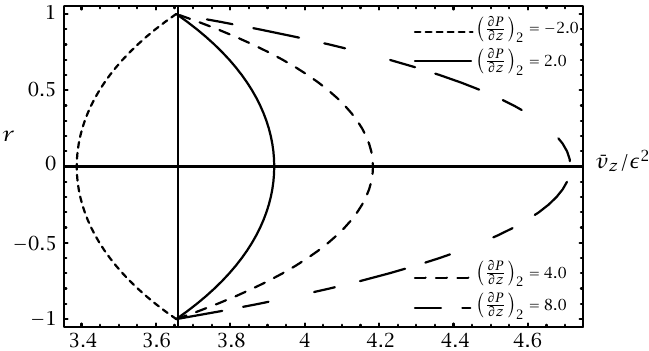
4 . 64 . 44 . 243 . 83 . 63 . 4